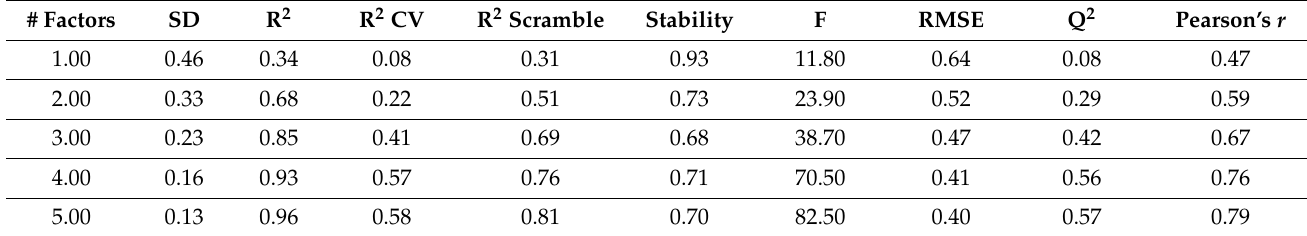
Table 3. Statistical data of atom-based QSAR model.